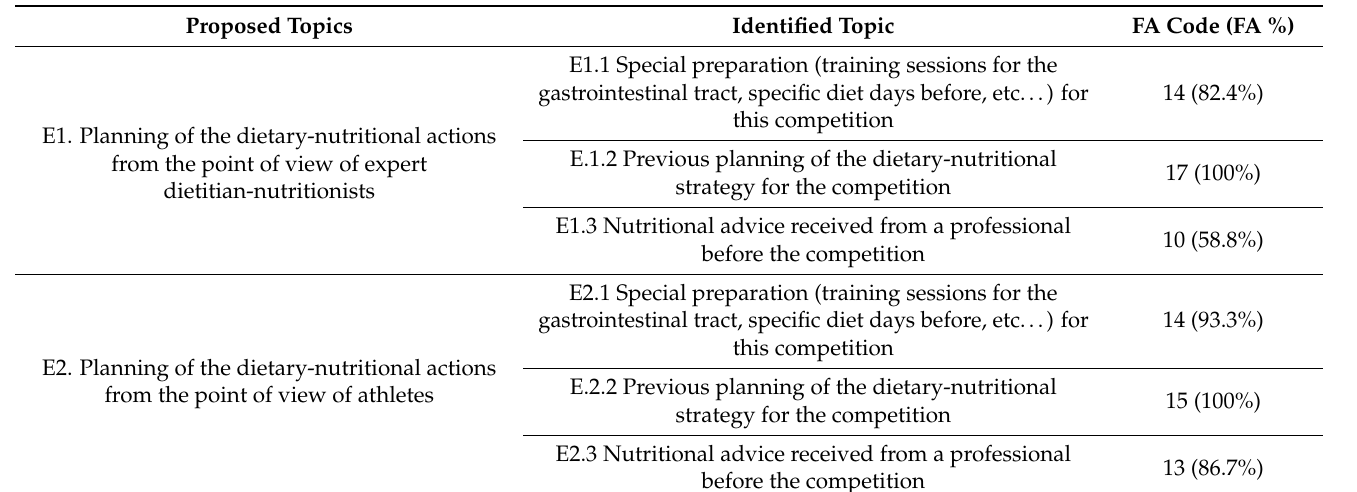
Table 5. Results of the focus groups for the content of part V of the questionnaire, related to the competition dietary-nutritional